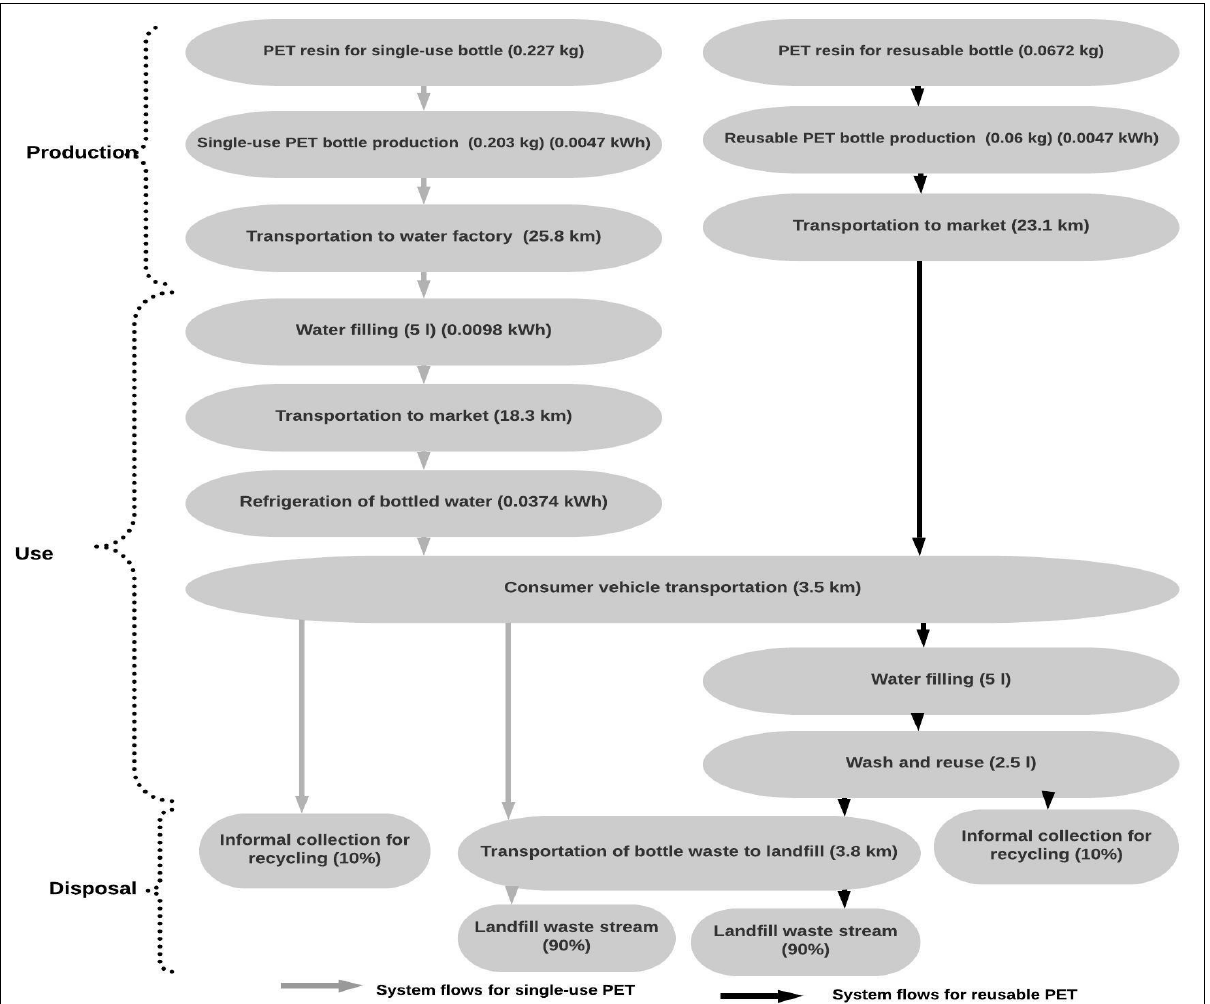
Figure 2: System boundaries of the life cycle of 10 single-use PET bottles and one reusable PET bottle as the functional